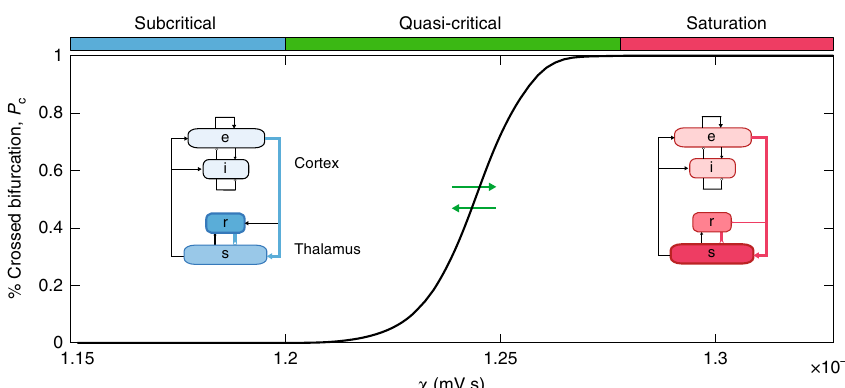
Fig. 2 Promoting quasi-critical states. The time averaged percentage of nodes that have crossed their bifurcation, P c , as a function of diffuse coupling, χ . We identi fi ed three qualitative zones: a low variability subcritical zone (blue), where no nodes crossed their bifurcation point for the full duration of the simulation, a highly variable, quasi-critical zone (green) where at least one node was below its bifurcation during the second half of the simulation, and a saturated, oscillatory zone (red). The insets show steady-state fi ring rates for each population within the neural mass model relatively represented via color